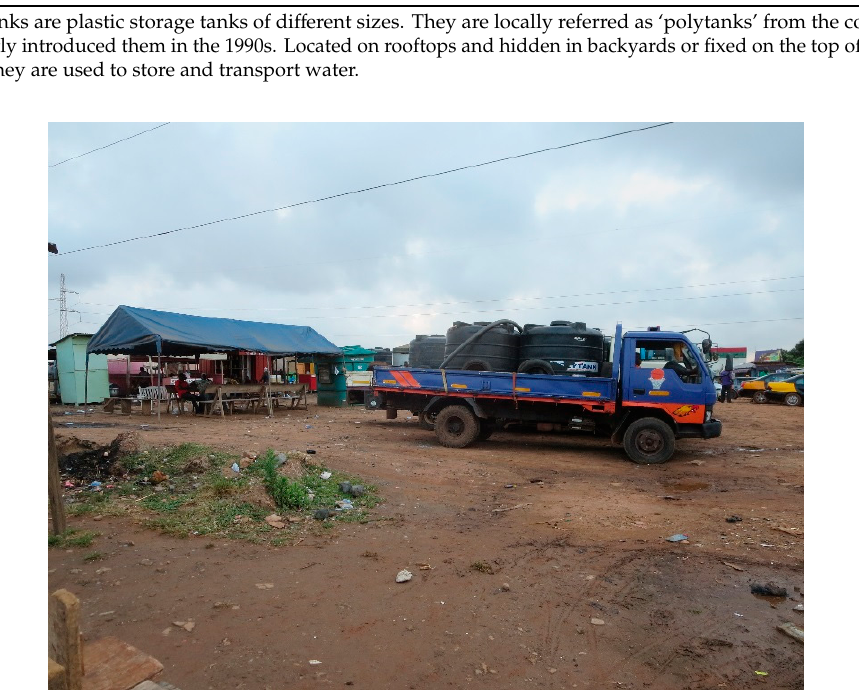
Table 1. Main characteristics of tanker water associations involved in the study. Source: authors’ fieldnotes, 2015.